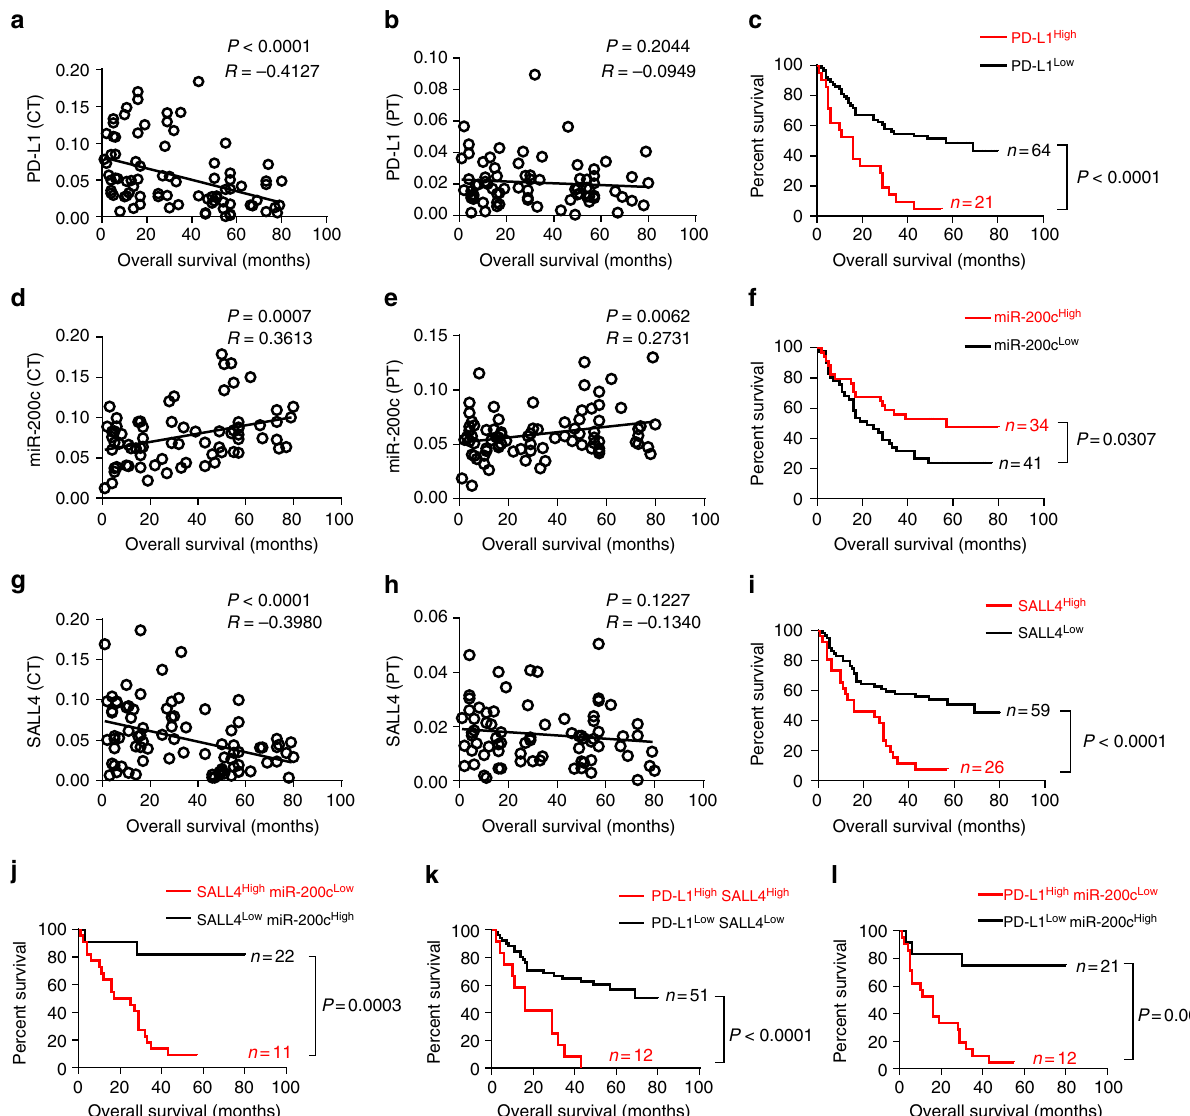
Fig. 3 Increased overall survival in patients with lower SALL4, higher miR-200c and lower PD-L1. a , b Correlation of PD-L1 expression in the center tumor and peritumor regions to overall survival (OS). c OS in patients with PD-L1 expression in the center tumor regions (log-rank test). d , e Correlation of miR- 200c expression in center tumor and peritumor regions to OS. f OS in patients with miR-200c expression in the center tumor regions (log-rank test). g , h Correlation of SALL4 expression in the center tumor and peritumor regions to OS. i OS in patients with SALL4 expression in center tumor regions (log-rank test). j – l OS in patients concurrently with SALL4 and miR-200c, or SALL4 and PD-L1, or miR-200c and PD-L1 (log-rank test). Pearson ’ s correlation coef fi cients ( r ) and P values are shown in Fig. a, b, d, e, g, and